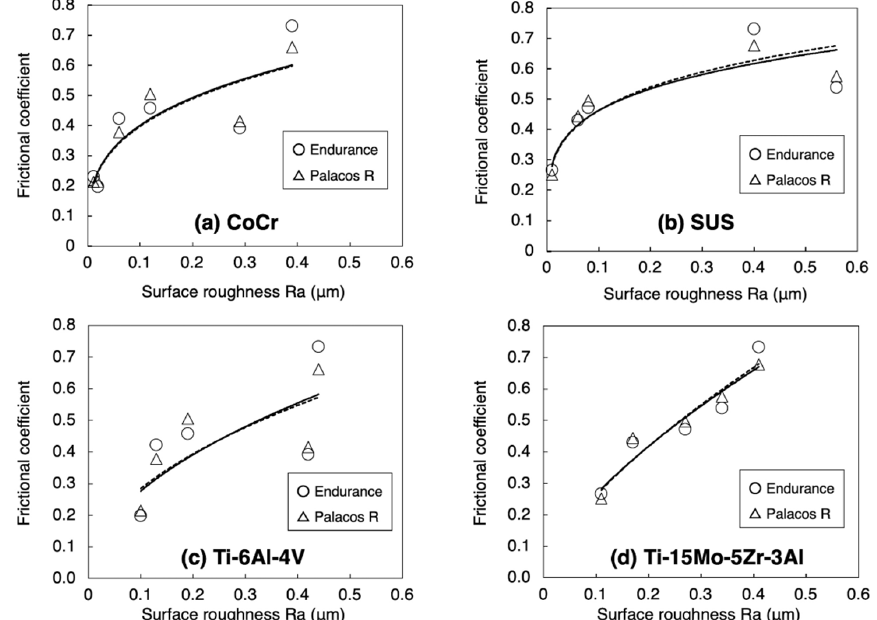
Figure 7. Relationship between the frictional coefficient and surface roughness: ( a ) CoCr, ( b ) SUS, ( c ) Ti-6Al-4V, and ( d ) Ti-15Mo-5Zr-3Al. The straight line and the dotted line indicate the power approximation fitted curve of Endurance (DePuy CMW, Blackpool, UK) and Palacos R (Heraeus Kulzer, Wehrheim, Germany).